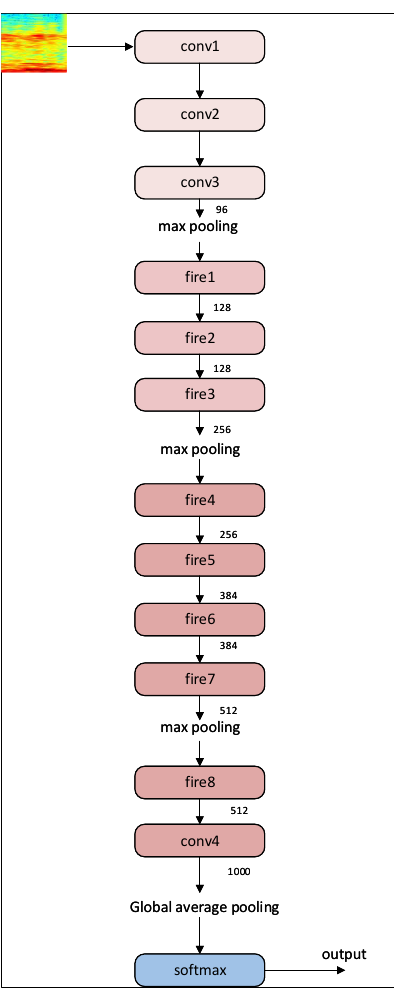
Figure 6. The fire module of S-ResNet classification model. The cross entropy loss function is used in conjunction with softmax in our model. The specific structure of S-ResNet classification model is shown in Table